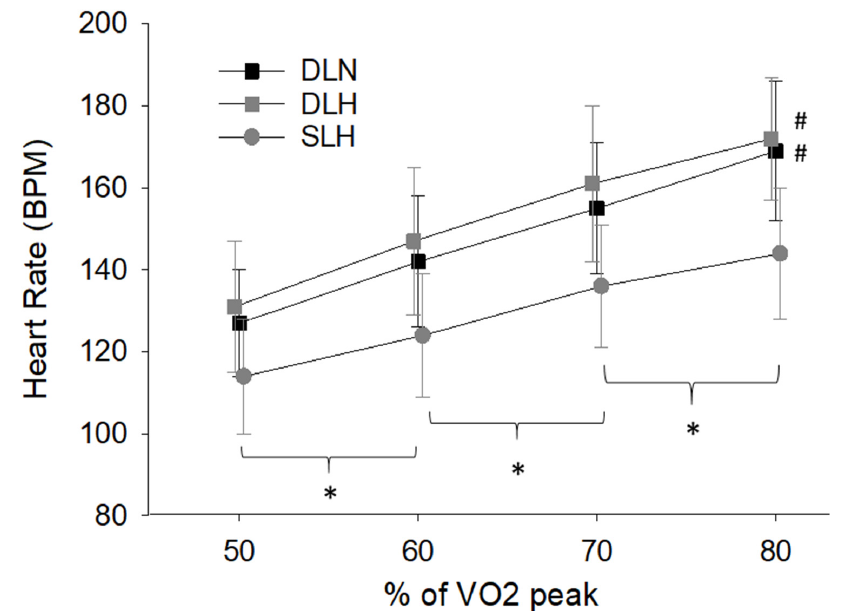
Figure 4. Changes in heart rate across the four different work rates. Heart rate was significantly lower during the single-leg cycling trial compared to the double-leg cycling trials ( p ≤ 0.004). There was no difference in heart between double-leg cycling in normoxia and hypoxia ( p = 0.23). * Indicates the significant increase in HR with each stage of exercise intensity. # Indicates the main effect of both DLH and DLN were different than SLH. DLN = Double-Leg Normoxia; DLH = Double-Leg Hypoxia; SLH = Sigle-Leg Hypoxia.